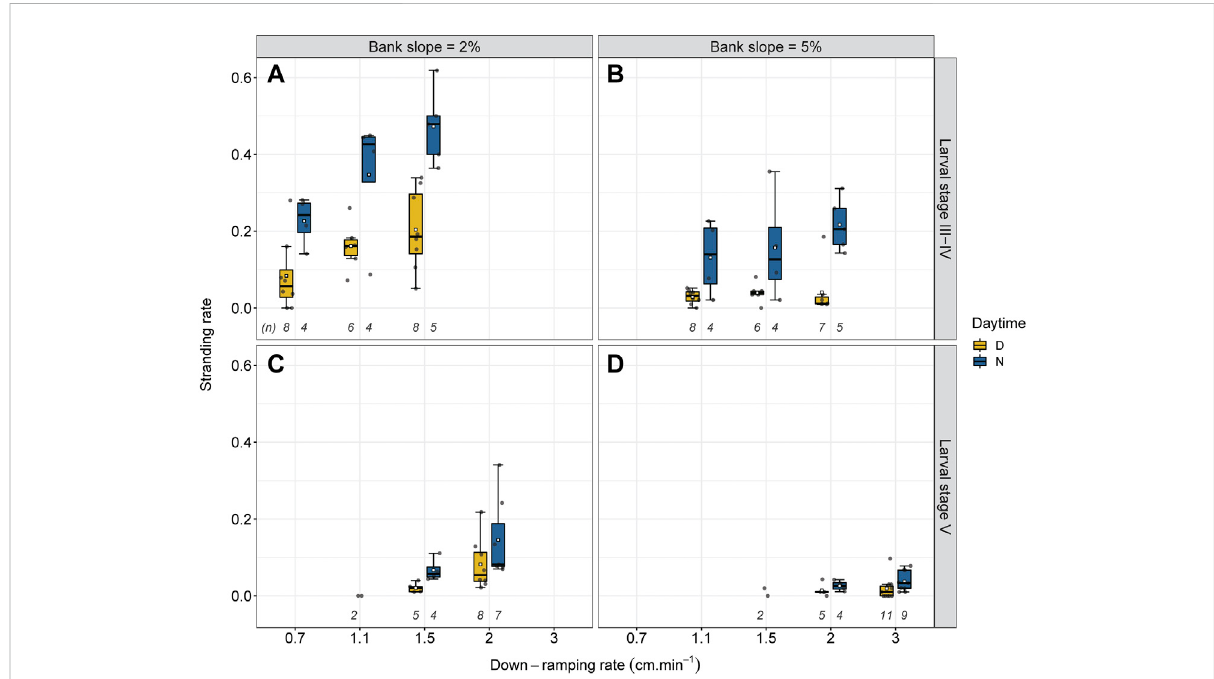
FIGURE 4 Strandingrateforthe22experimentalscenariosdependingonthedown-rampingrate(0.7 cm min − 1 ;1.1 cm min − 1 ;1.5 cm min − 1 ;2.0 cm min − 1 ; 3.0 cm min − 1 )withnumberofreplicates(n).Experimentswereperformedwith withlarvalstages III-IV (A,B) andV (C,D) at2% (A,C) and5% (B,D) bank slope, both during the day (D) and during the night (N). The boxplots with the associated bold lines and whiskers refer to median values and interquartile ranges. White squares indicate the mean value. The gray dots represent individual